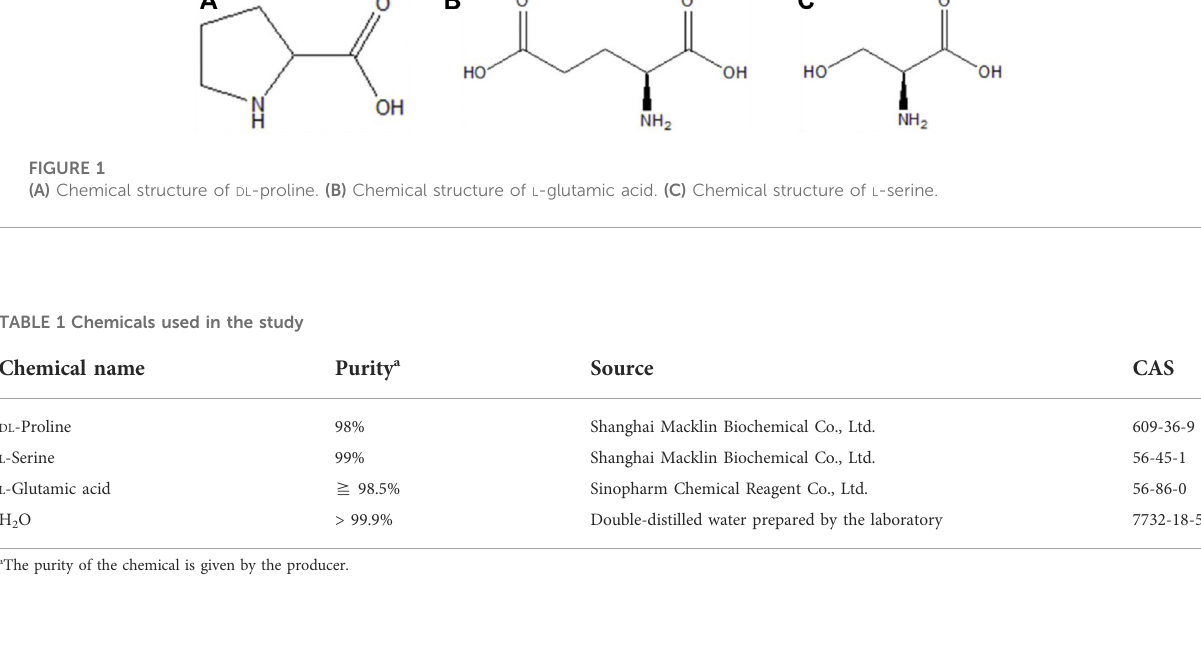
TABLE 2 Experimental VLE data for temperature T, pressure P, and molality m for the DL -proline + H 2 O system a